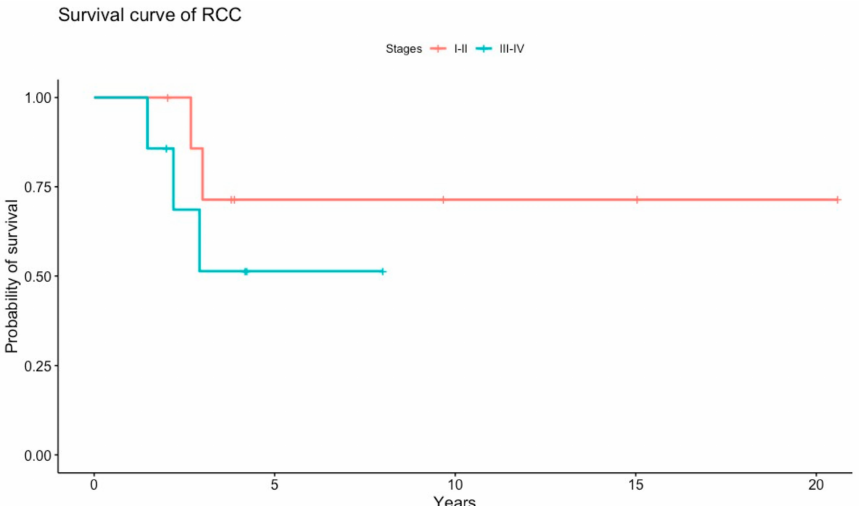
Figure 4. Kaplan-Meier estimates of overall survival of patients with renal cell cancer stages I and II vs. stages III and IV. RCC, renal cell cancer.